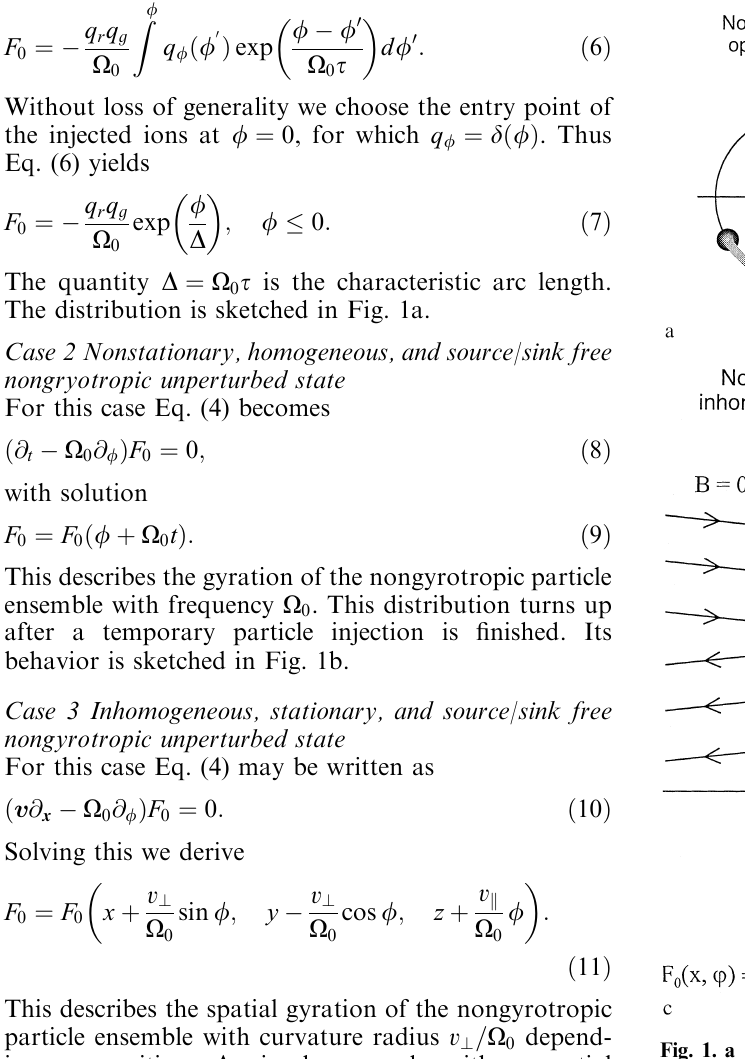
phase space; the ion ensemble gyrating in the (cid:118) x (cid:255) (cid:118) y plane sketched at three time-spots t 1 < t 2 < t 3 . c Inhomogeneous nongyrotropic distri- bution; the upper part represents a spatial inhomogeneity by a magnetic field jump; the lower par shows the corresponding nongyrotropy in phase